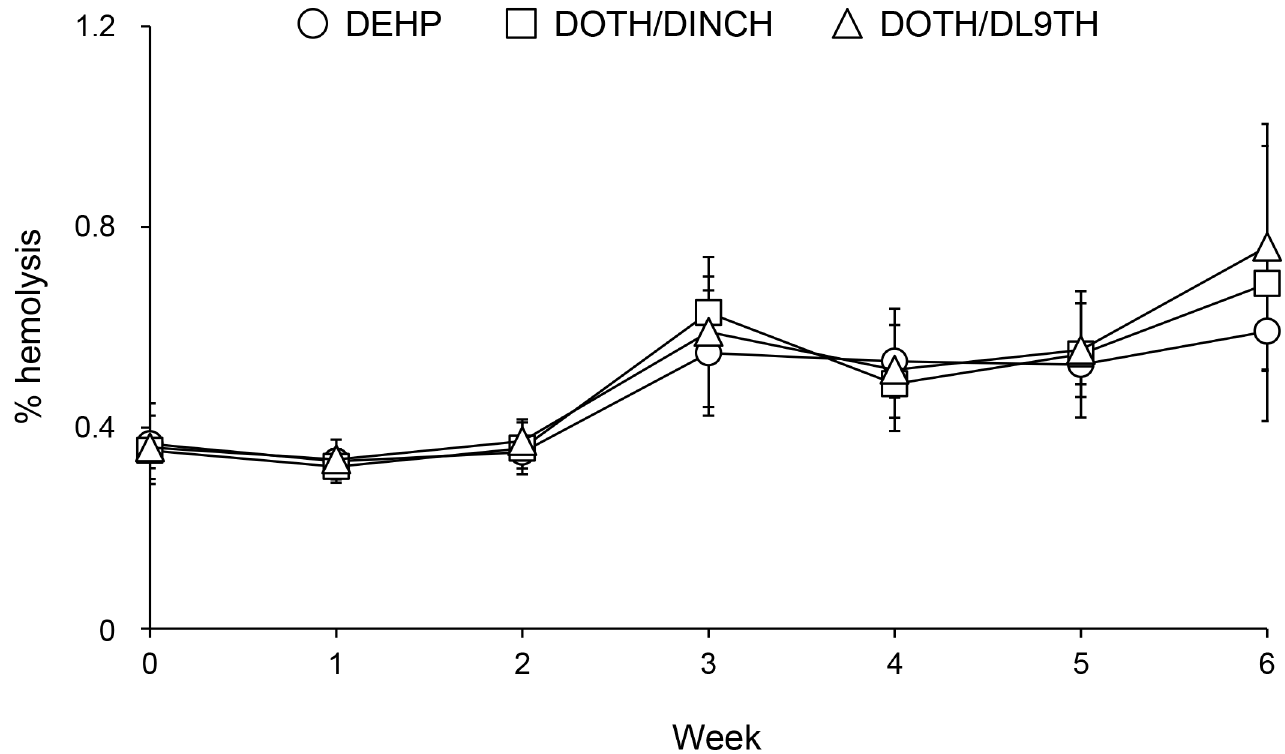
Fig 1. Hemolysis of stored MAP/RCC. Data are reportedas mean ± standard deviation(SD; n = 6).